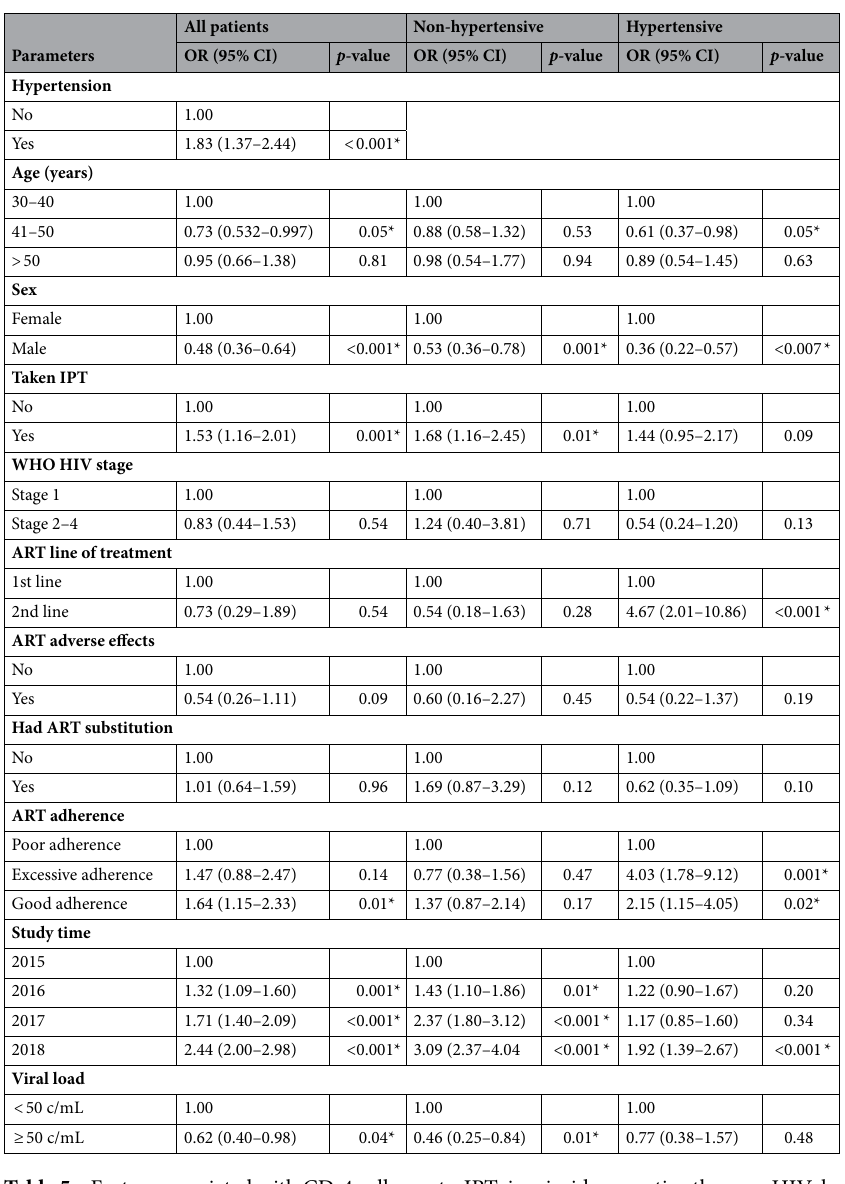
Table 5. Factors associated with CD-4 cell counts. IPT: isoniazid preventive therapy; HIV: human immunodeficiency virus; > : greater than; ≥ : greater than or equals to; CI: confidence interval; < : less than; OR: odds ratio; –: independent variable has colinearity with independent variable; 1.00: reference. *Statistically significant